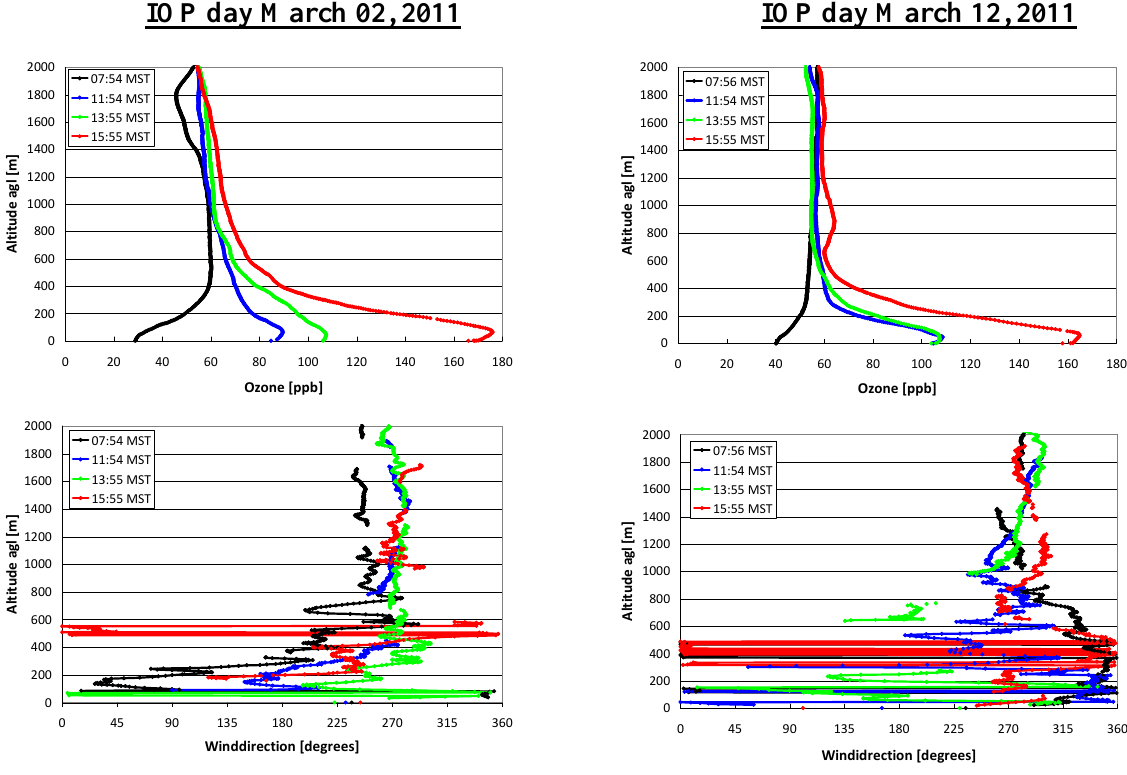
Figure 6. Profiles of ozone (above) and wind direction (below) on IOP days 2 March 2011 (left) and 12 March 2011